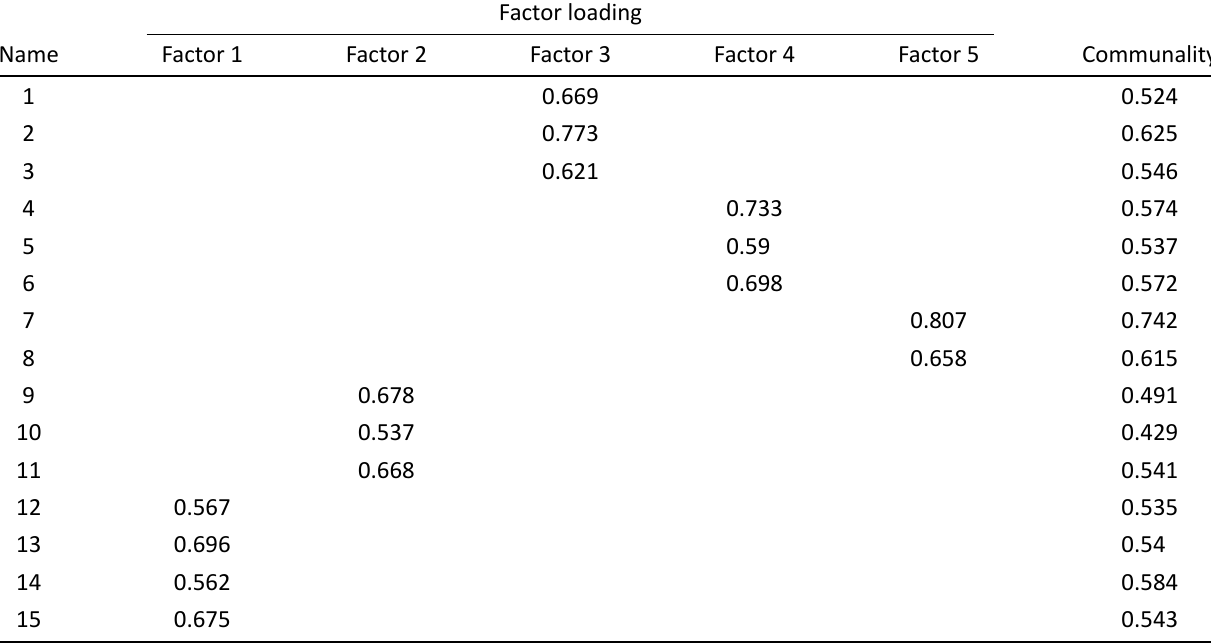
Table 3. Factor loading (rotated).